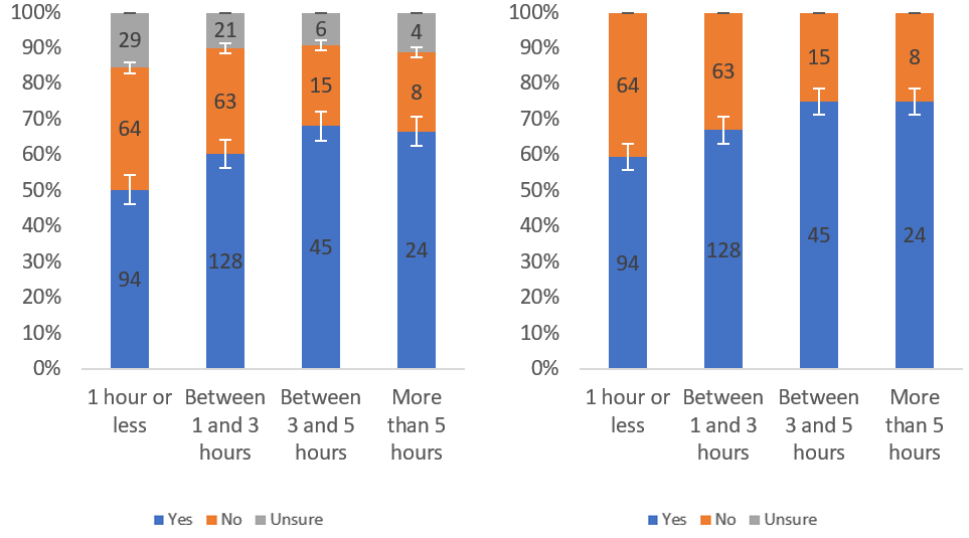
Figure 57. Responses regarding label helpfulness by internet usage level including ( left ) and excluding ( right ) unsure responses.